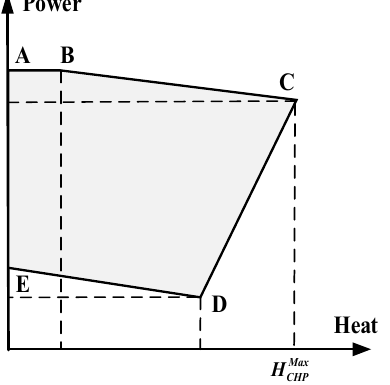
Figure 3. A typical heat-power feasible operation region (FOR) of CHP units.